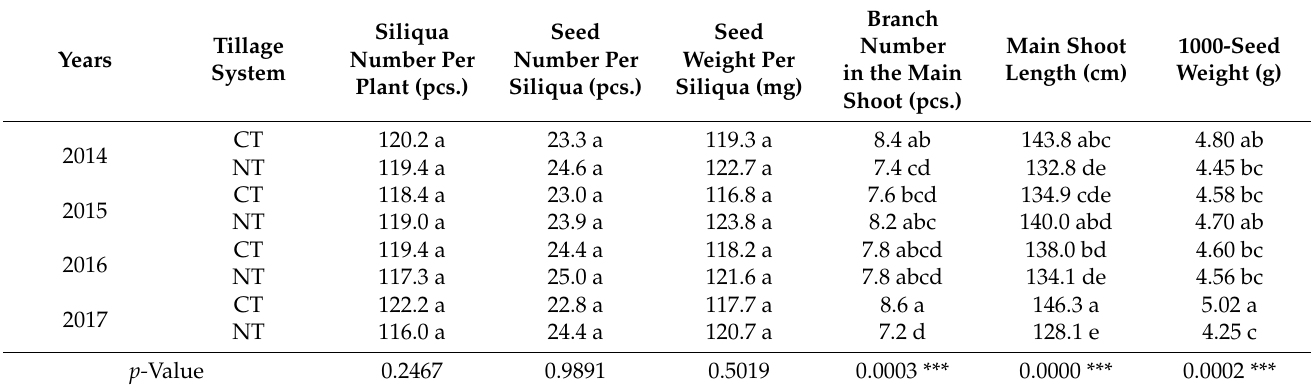
Table 4. Interactive dependencies of tillage systems and years of research in determining winter oilseed rape yield and crop